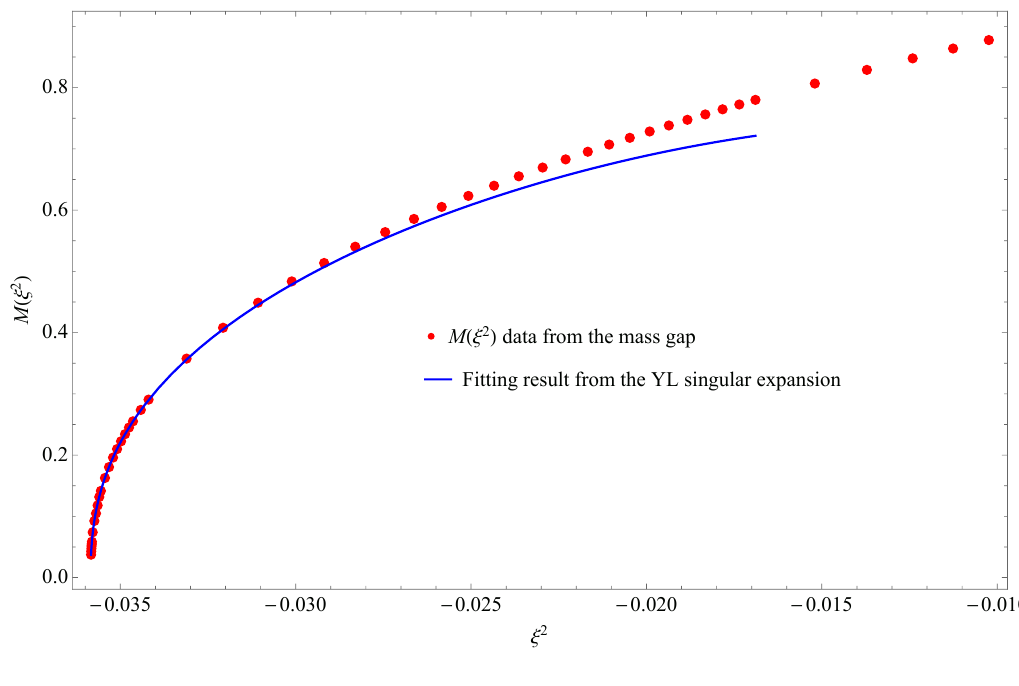
Figure 16 . 3-parameter fitting of M ( ξ 2 ) from the singular expansion, via eq.